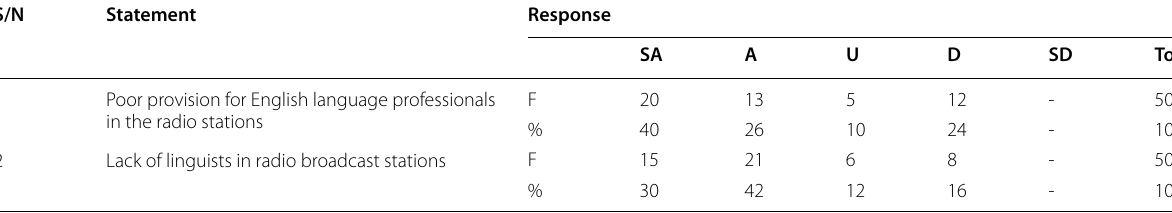
Table 13 Challenges in communicating in English language in the radio stations in Hunan (Staff response)